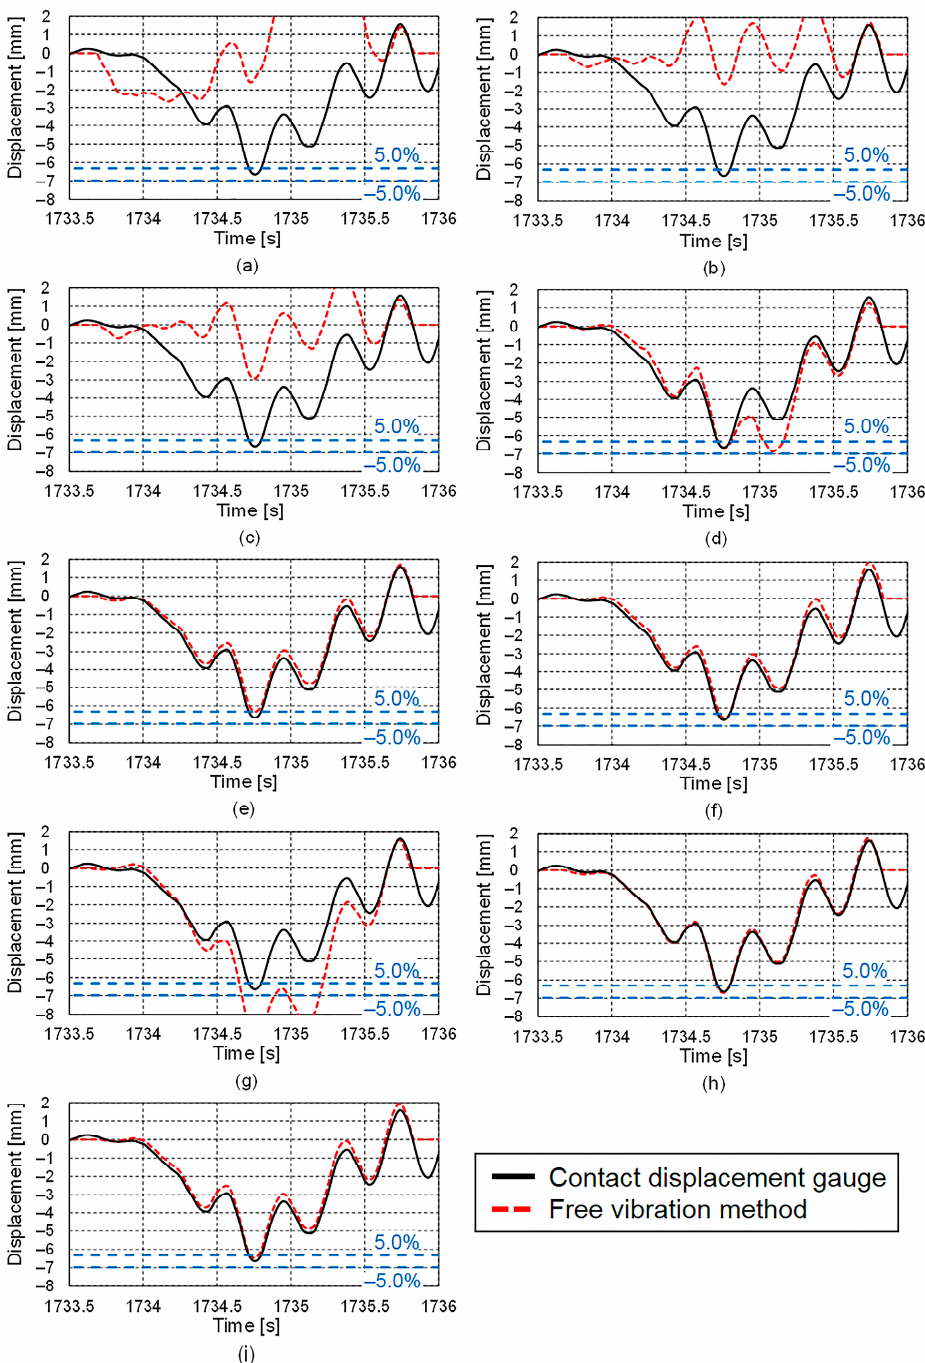
Figure 13. Displacement responses obtained using proposed free vibration separation method: ( a ) Accelerometer A; ( b ) Accelerometer B; ( c ) Accelerometer C; ( d ) Accelerometer D; ( e ) Accelerometer E; ( f ) Accelerometer F; ( g ) Accelerometer G; ( h ) Accelerometer H; ( i ) Servo-type